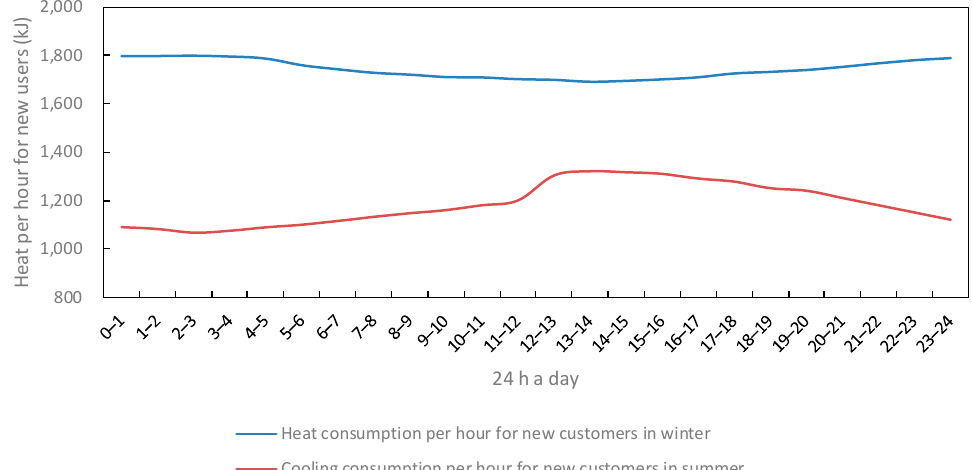
Figure 10. Change in heat consumption of new load users.